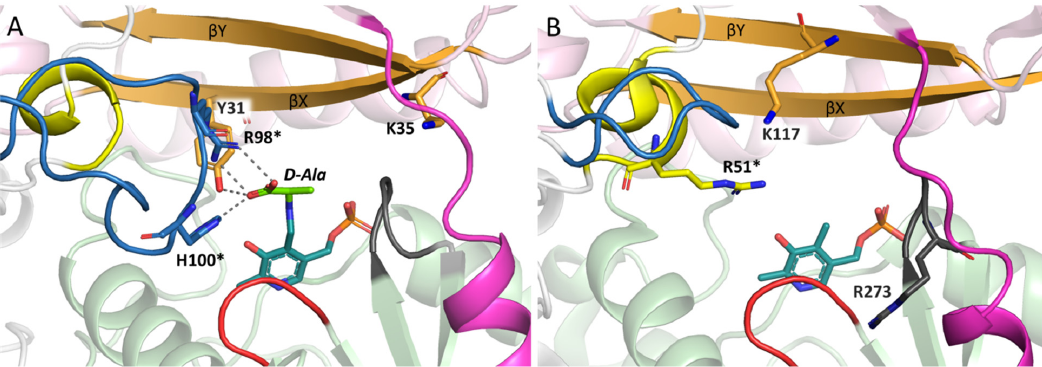
Figure 1. Variants of the active sites in DAATs. ( A ) The active site of bsDAAT in complex with D-alanine (PDB ID 3DAA). ( B ) The active site of CpuTA (PDB ID 5K3W). The small domain of one subunit is colored in light green, the large domain—in light pink, and the adjacent subunit—in grey. The O-pocket α -helix is colored in yellow, the O-pocket loop—in blue, the β X- and β Y-strands—in orange, the interdomain loop—in magenta, the β -turn1—in red, and the β -turn2—in black. PLP molecule and important residues are shown in sticks. The O-pocket is to the left from PLP, the P-pocket is to the right from PLP. Residues of the adjacent dimer subunit are marked with asterisks. Herein, we report insights into substrate binding in DAAT from the gram-negative mesophilic bacterium Aminobacterium colombiense (AmicoTA) [33]. Using kinetic analysis, we observed the activity of AmicoTA toward different D-amino acids, with D-glutamate being the most specific substrate. Structure-based sequence alignment revealed the iden- tical active site residues between AmicoTA and both canonical and non-canonical DAATs.